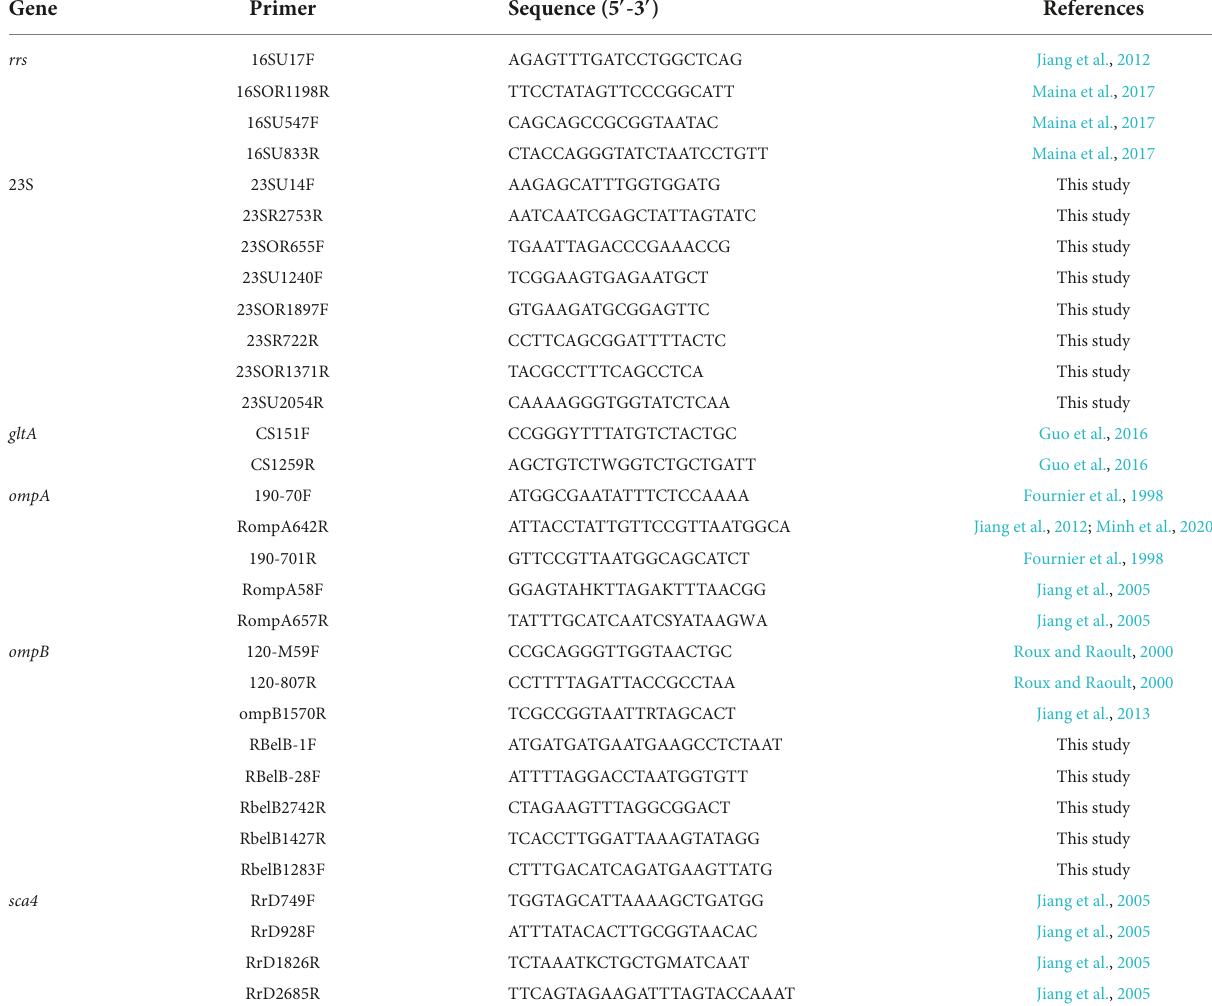
TABLE 1 Primers used for PCR, nested PCR, and Sanger